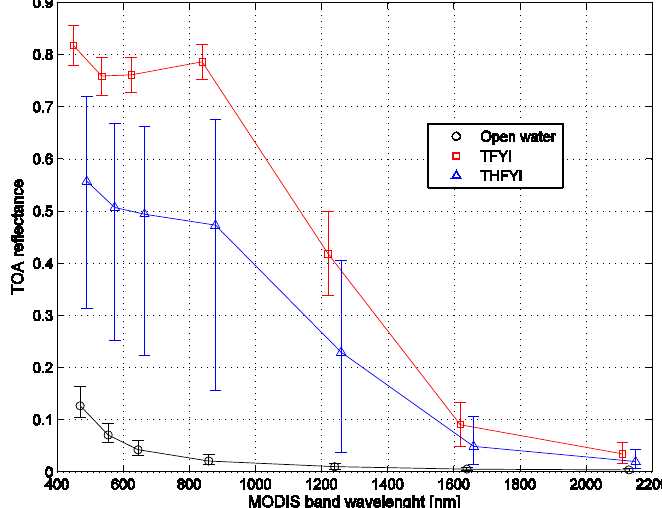
Figure 3. The MODIS TOA reflectance spectra for open water, thin first-year ice (THFYI) and thick first-year ice (TFYI) under winter conditions in the Kara Sea in May 2009. THFYI includes nilas, young ice, and pancake ice, and its surface may be snow-free or covered with thin snow layer. The vertical lines show 90% variation interval of the measured TOA reflectances. The MODIS bands from left to right are 3, 4, 1, 2, 5, 6, and 7.